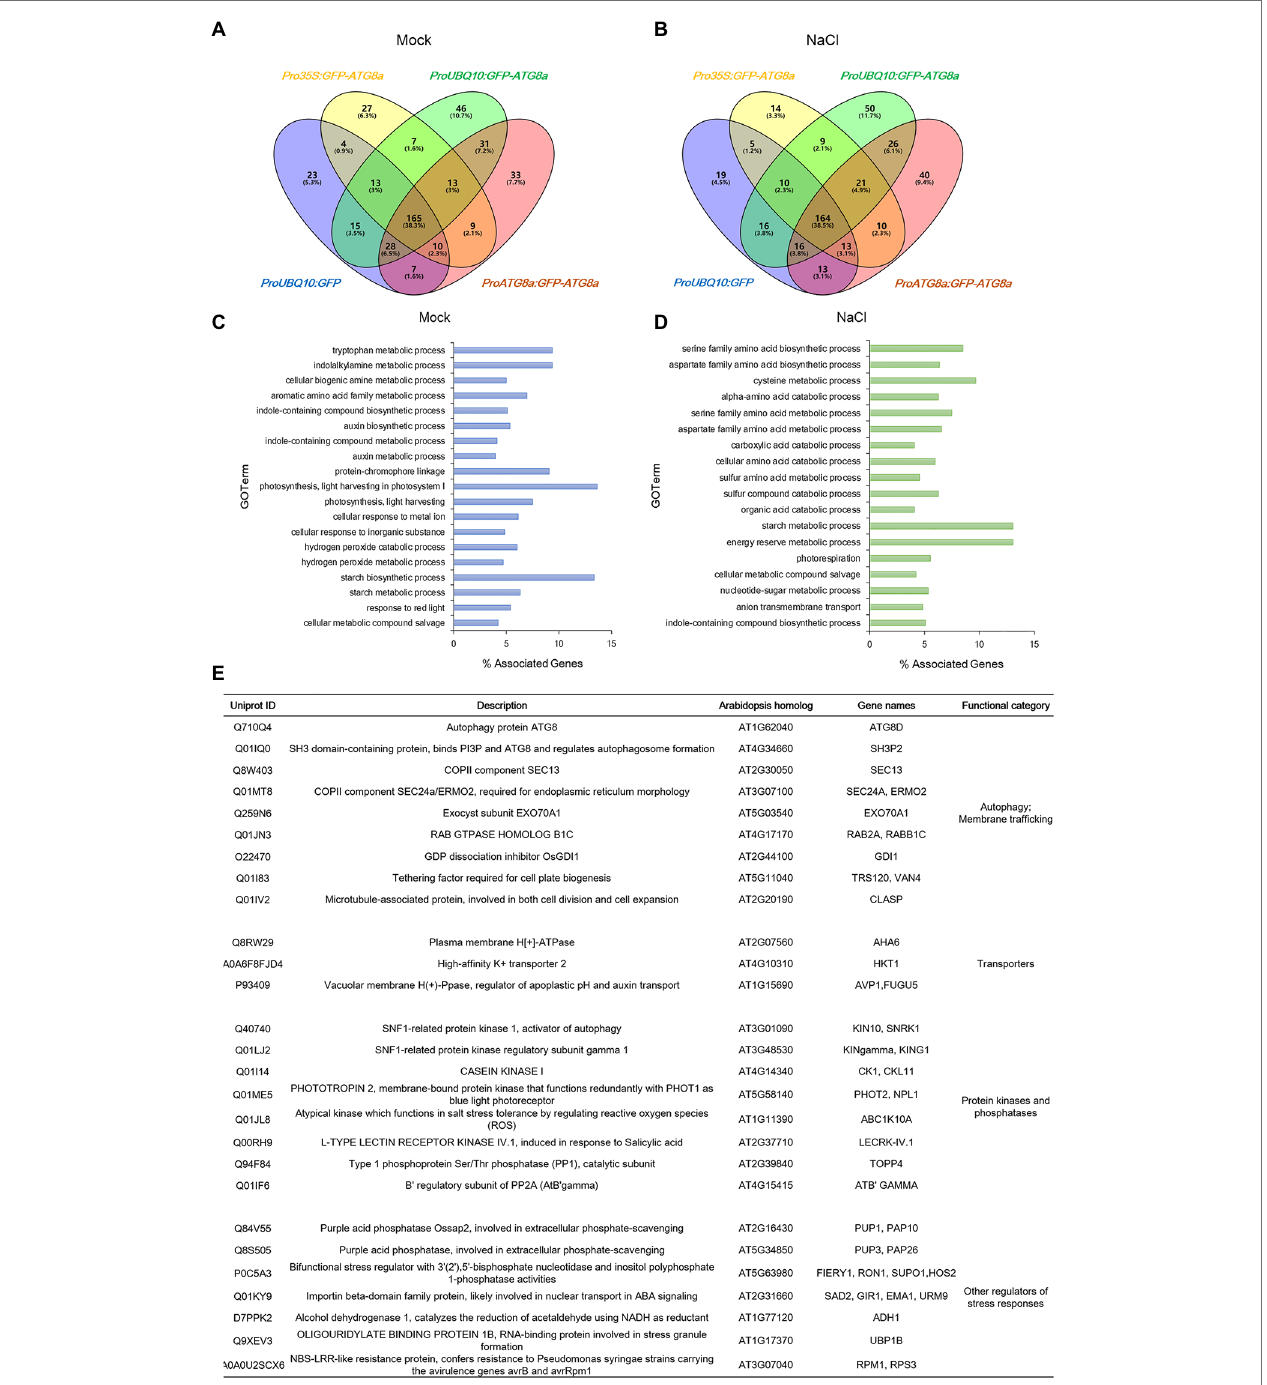
FIGURE 5 | Identification of new ATG8-interacting proteins with immunoprecipitation-mass spectrometry analyses on GFP-OsATG8a marker lines. (A) Venn diagram showing the overlap in the number of proteins identified from three GFP-OsATG8a lines and the GFP control line, under normal growth condition (Mock). (B) Venn diagram showing the overlap in the number of proteins identified from three GFP-OsATG8a lines and the GFP control line, treated with 150 mM NaCl for 1 h (NaCl). (C) Gene Ontology (GO)-Biological Process (BP) enriched in all OsATG8a-interacting proteins (166 in total) identified from the three transgenic lines under normal growth condition (Mock). (D) GO-BP enriched in all 170 OsATG8a-interacting proteins identified after salt stress (NaCl). (E) Selected OsATG8a-interacting proteins, including regulators of autophagy and other trafficking routes, plasma membrane and tonoplast transporters, protein kinases and phosphatases, and other regulators of stress